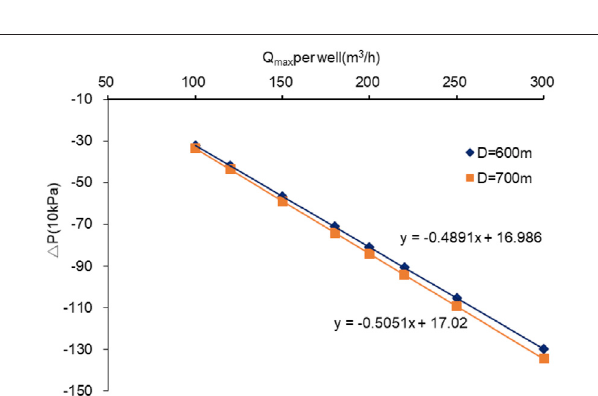
FIGURE 8 | The relationship of maximum drawdowns and different water yields when the well spacing is 600 m and 700 m.